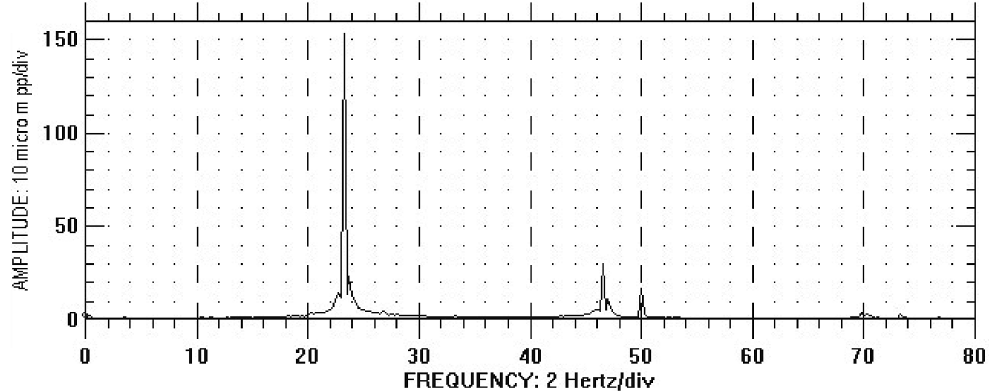
Fig. 9. Frequency spectrum of the vibrations measured on the support #2 (direction Y) during the occurrence of abnormal vibration levels.